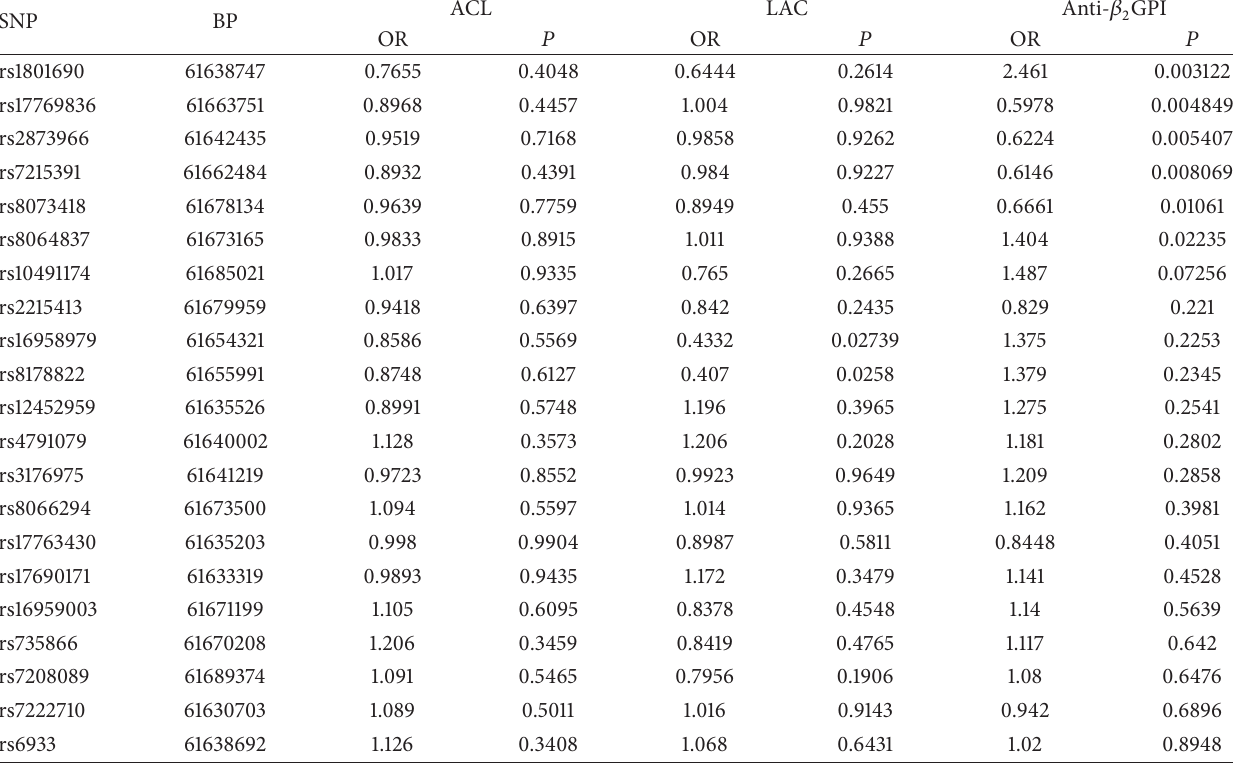
Table 7: Odds ratios and P -values for the association analysis of APOH SNPs on chromosome 17 with ACL, LAC, and anti- 𝛽 2 GPI ∗